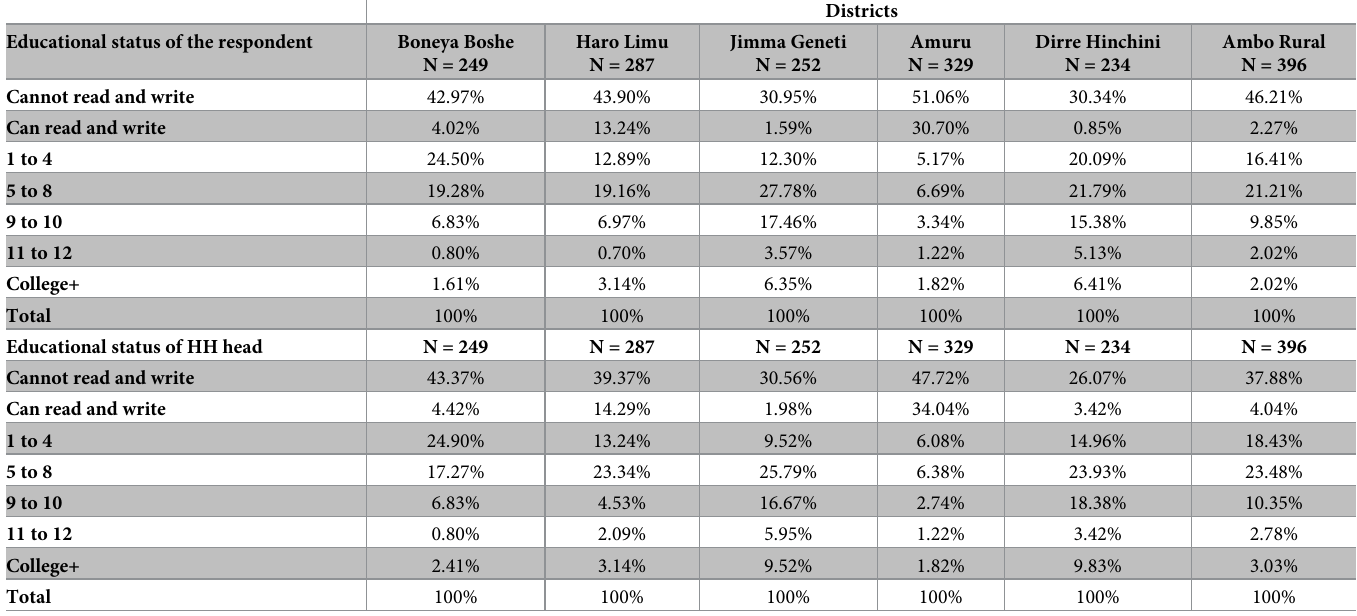
Table 1. Educational status of respondents and HH heads among six districts of East Wollega, Horo Guduru Wollega and West Shewa zones survey population, 2017.